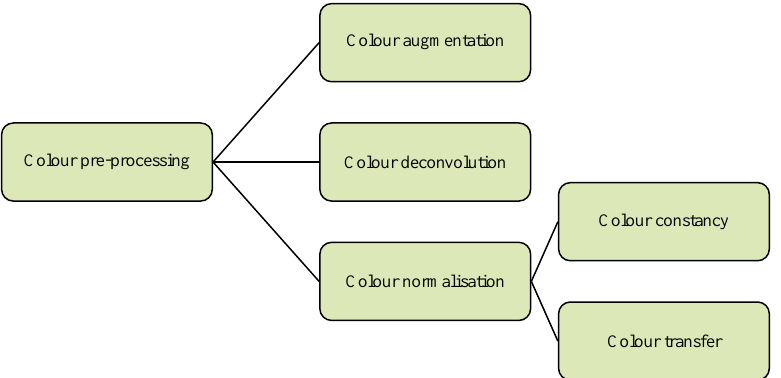
Figure 2. Color pre-processing for histological images: a